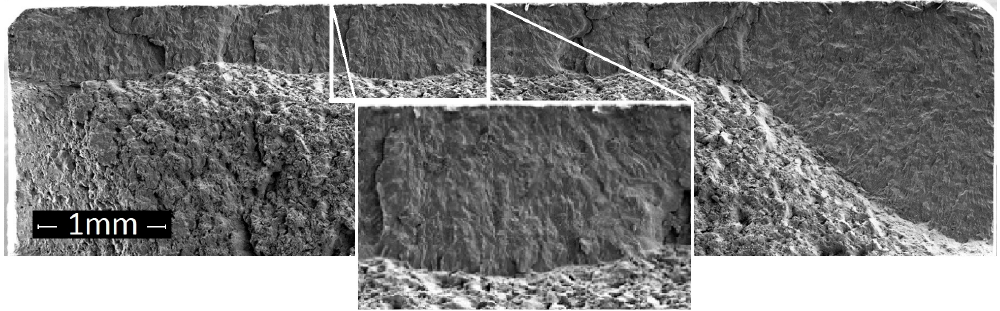
Figure 11. Fracture surface of a specimen with Load Combination 2, without shot peening and a fatigue life of 126,496 cycles.